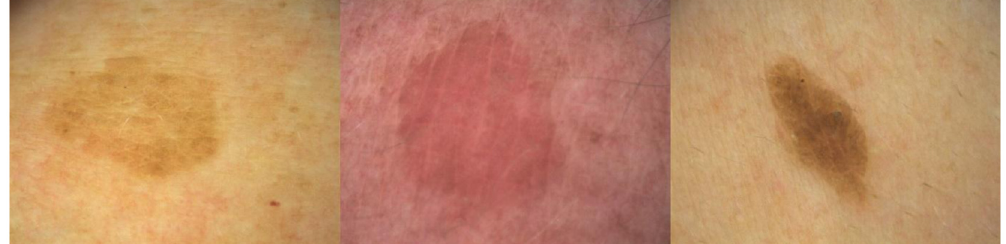
Figure 2. Reticulate seborrheic keratoses missing horn cysts. This type is more common in ultraviolet-exposed skin areas. This figure is an original image created by the author for this publication and written informed consent was obtained from the